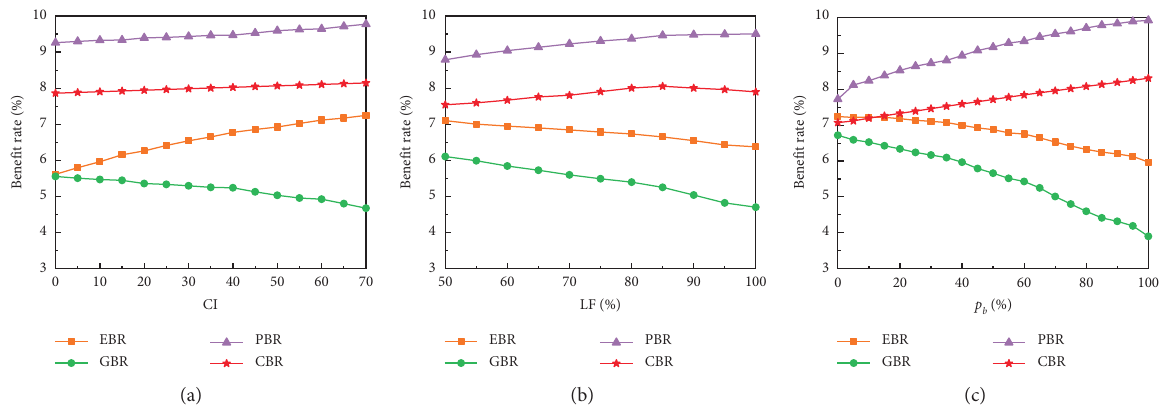
Figure 8: Comparative monthly results about SATO performance with different values of CI, LF, and p